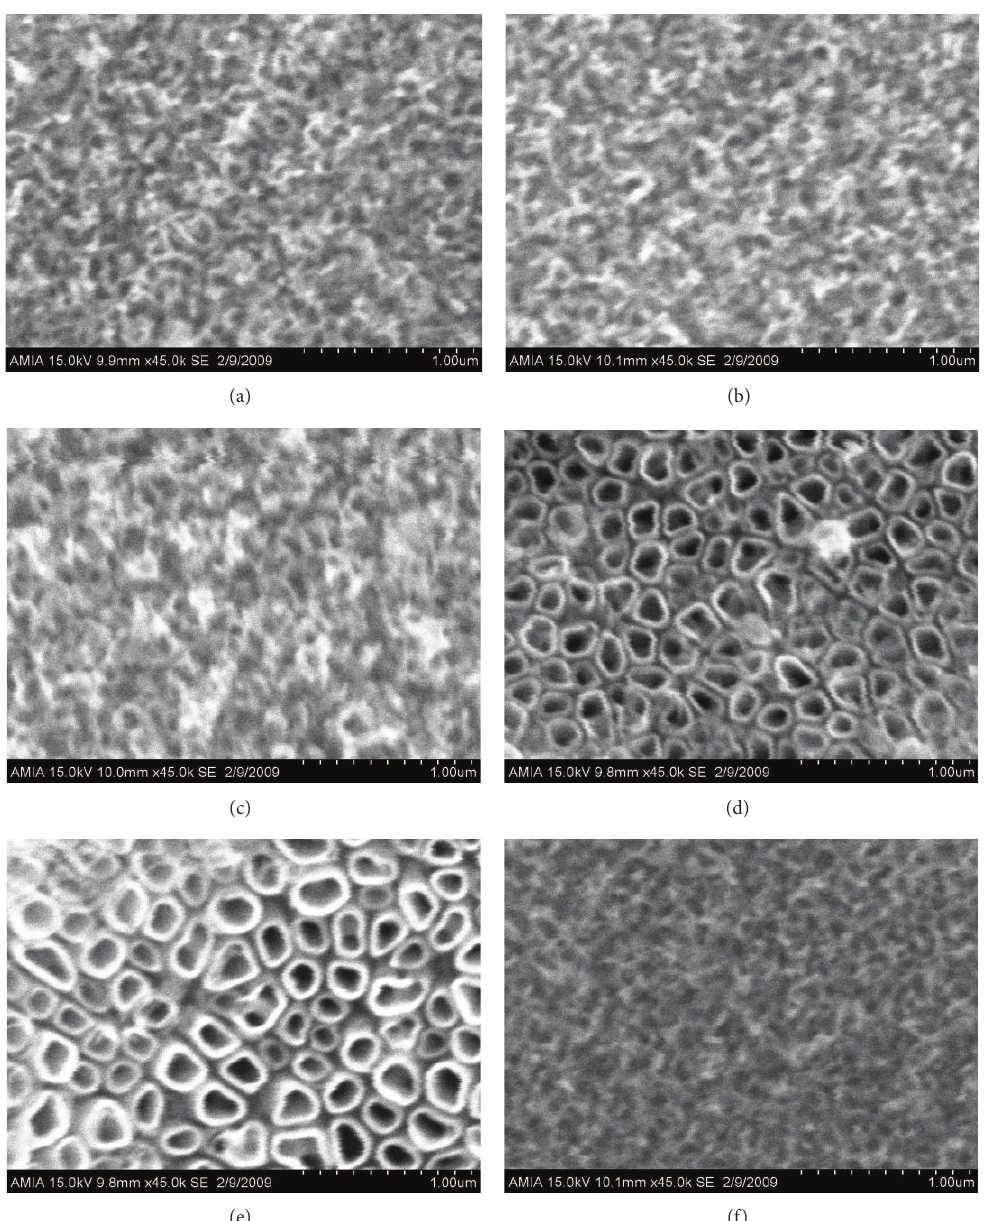
Figure 1: Top view of SEM images of TNT synthesized at different weight ratios of glycerol and water: (a) 1:9, (b) 2 :8, (c) 4 :6, (d) 6:4, (e) 8:2, and (f)